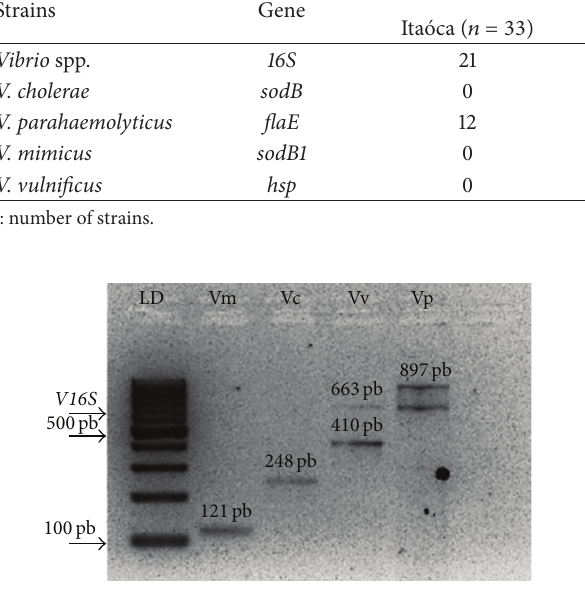
Figure2:Ampliconsofspecific Vibrio genes.LD:molecularmarker; Vm: V. mimicus , Vc: V. cholerae , Vv: V. vulnificus , and Vp: V. para-